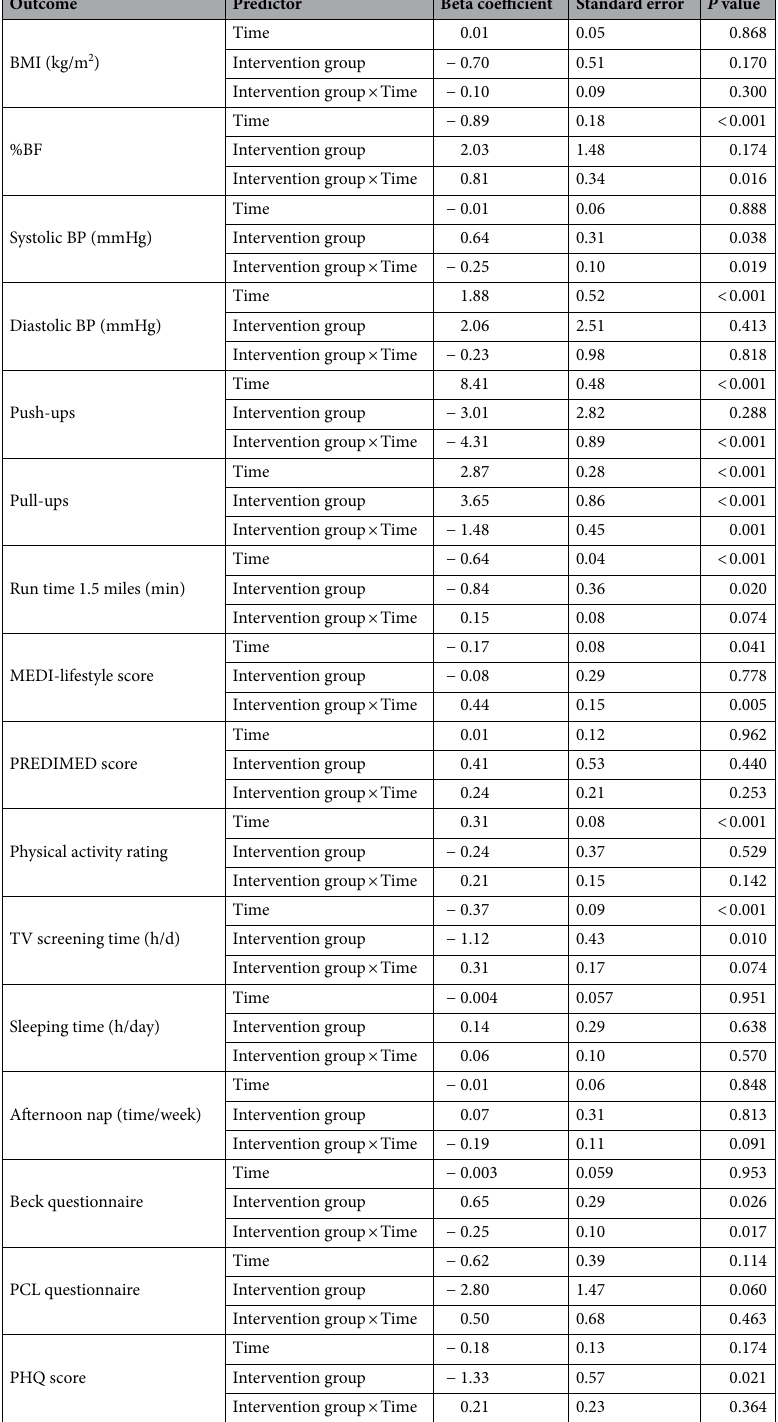
Table 3. Multivariable adjusted selected health profiles comparing the academy training effects on the intervention group (N = 55) to the historical control group (N = 92). Statistics derived from age, sex, baseline %BF, baseline push-ups, and/or baseline Beck score adjusted mixed effects models. BMI, %BF, blood pressures, push-ups, pull-ups, run time, and MEDI-lifestyle score are only available for one academy of the intervention group (n = 37). BMI body mass index, %BF percent body fat, BP blood pressure, Beck Beck depression inventory for primary care, PCL post-traumatic stress disorder (PTSD) questionnaire, PHQ patient health